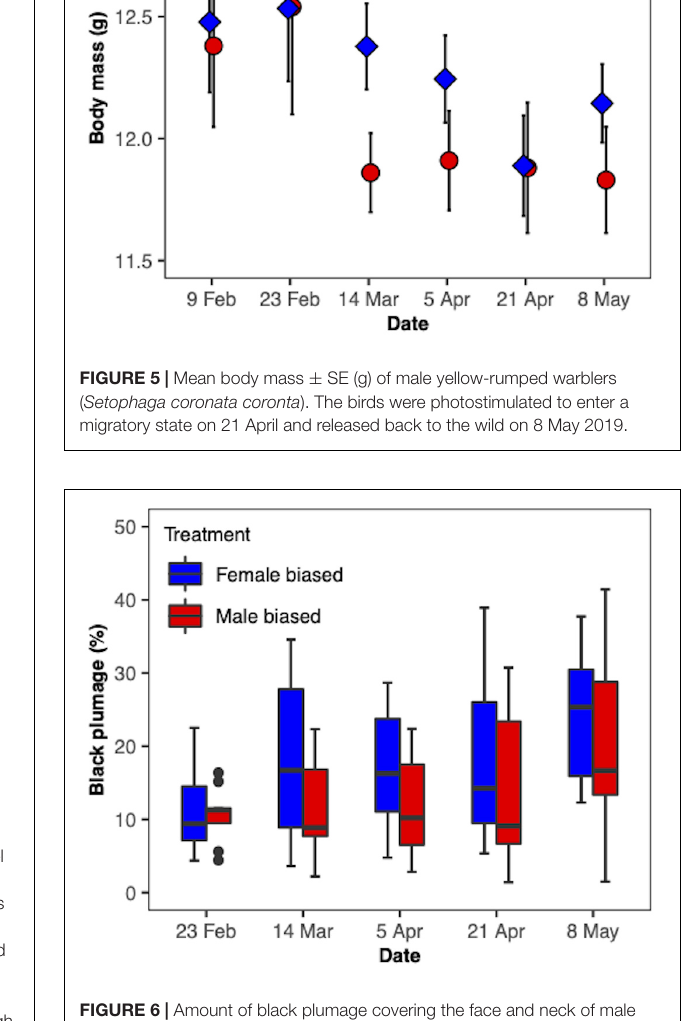
FIGURE 6 | Amount of black plumage covering the face and neck of male yellow-rumped warblers ( Setophaga coronata coronata ) over